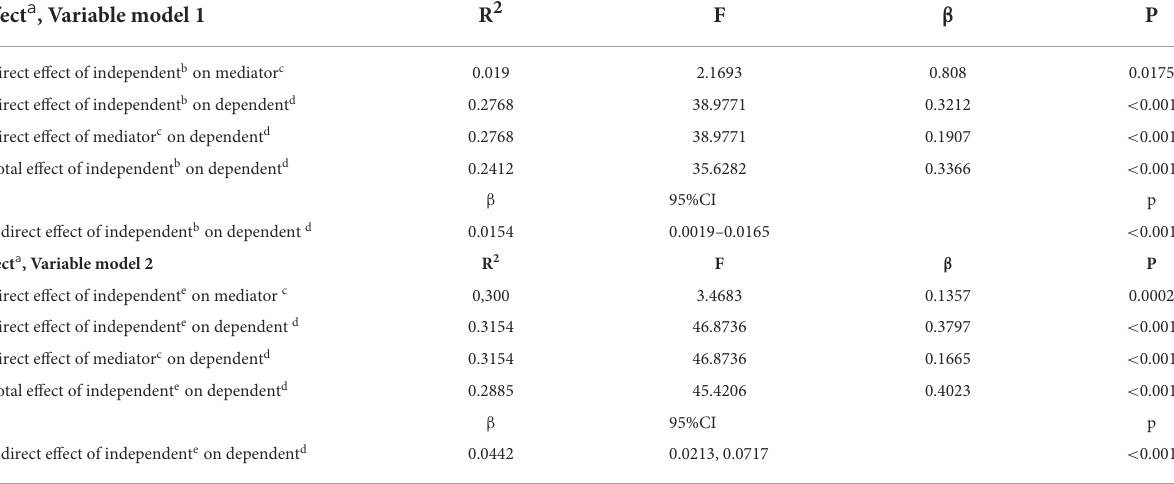
TABLE 2 Result from PROCESS macro testing expressive suppression mediation model 1 and model